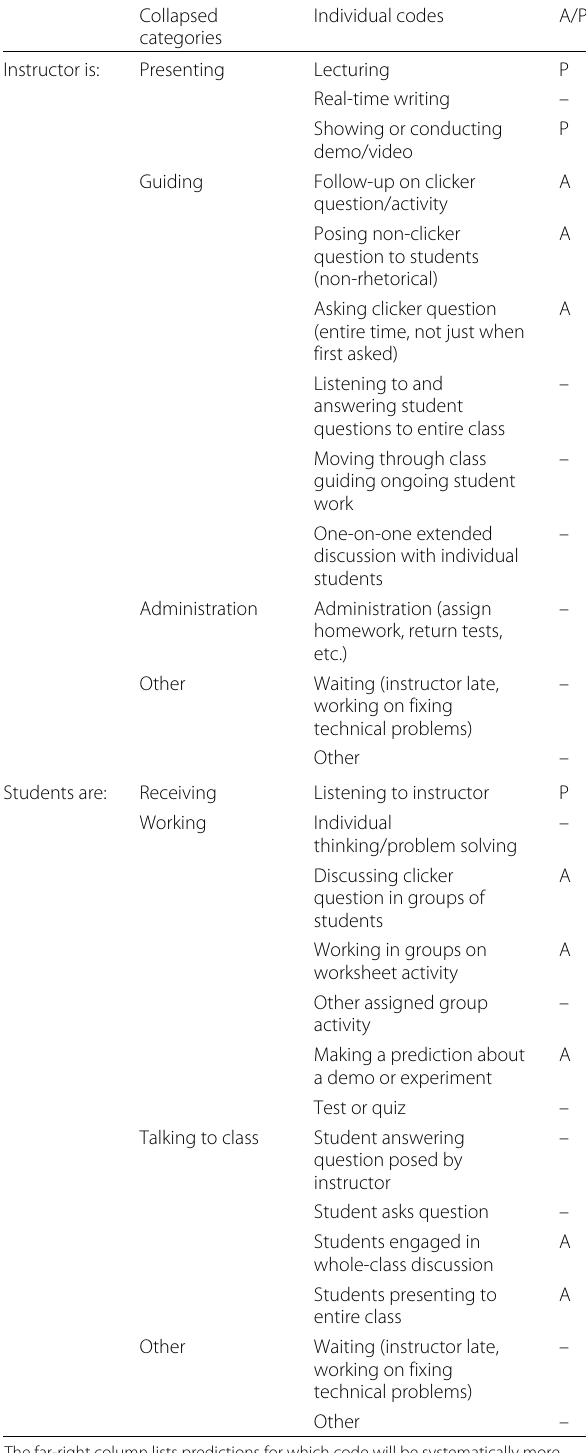
Table 1 List of individual COPUS codes (from Smith et al. 2013) by their collapsed categories (from Smith et al.